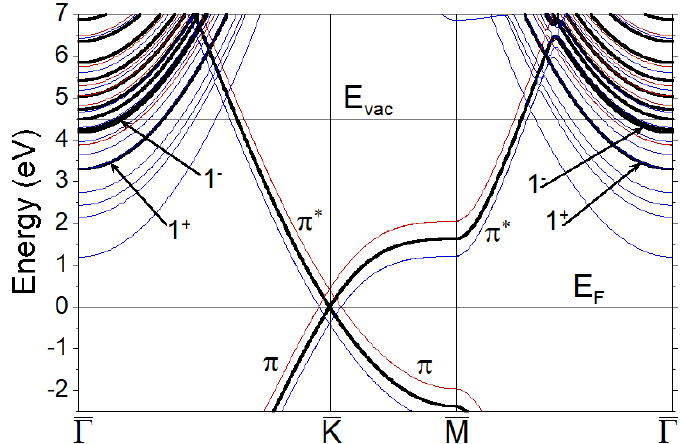
Figure 2. Electronic band structure of graphene when E = 0 (thick black lines), 0.4 V/Å (thin red lines), and − 0.4 V/Å (thin blue lines) obtained with application of the geometry of Figure 1a. The Fermi level, E F , is placed at zero energy. The position of the vacuum level, E vac , is shown for the zero field. The π and π ∗ bands are marked by corresponding symbols. The two unoccupied lowest energy states around the Γ point with strong localization in the vacuum are marked as 1 + and 1 − according to the Ref.